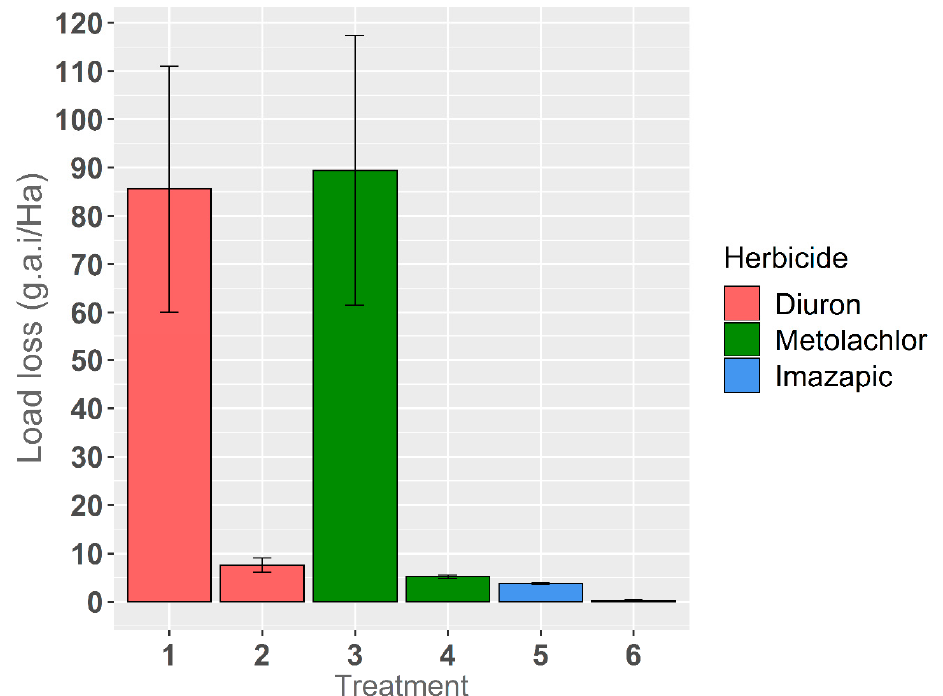
Figure 3. Average loads (±variance) of residual, ‘pre-emergent’ herbicides (g.a.i/ha) leaving each irrigation treatment in surface water. Treatments: 1—Metolachlor broadcast; 2—Metolachlor banded; 3—Diuron broadcast; 4—Diuron banded; and 5—Imazapic broadcast; 6—Imazapic banded.